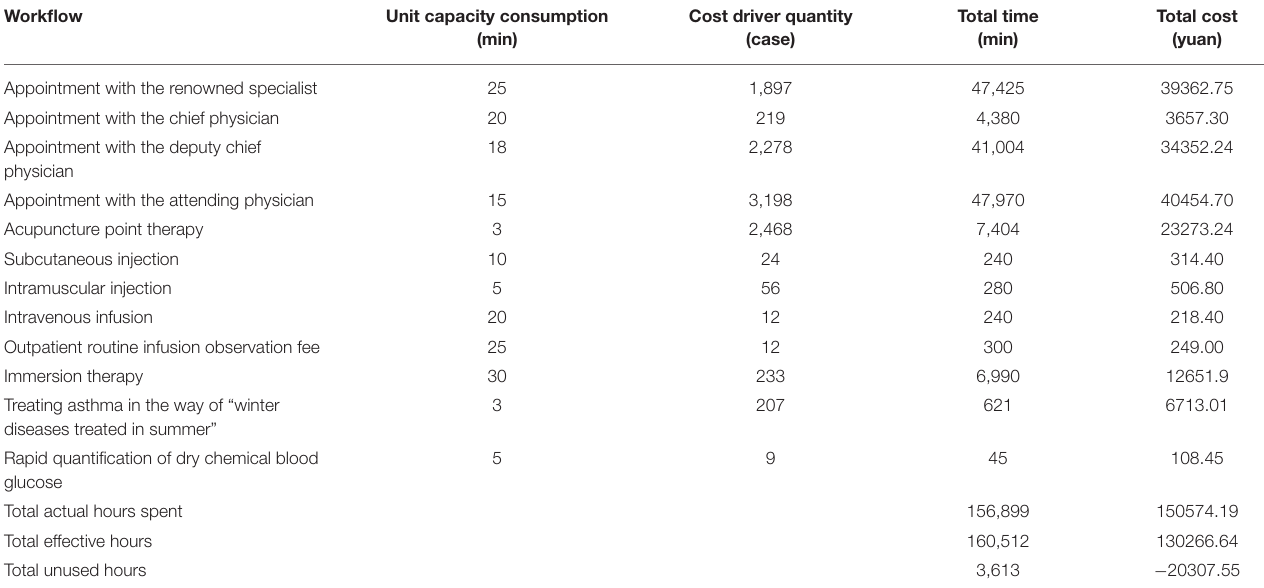
TABLE 7 | Idle production capacity of each operation in the B department.